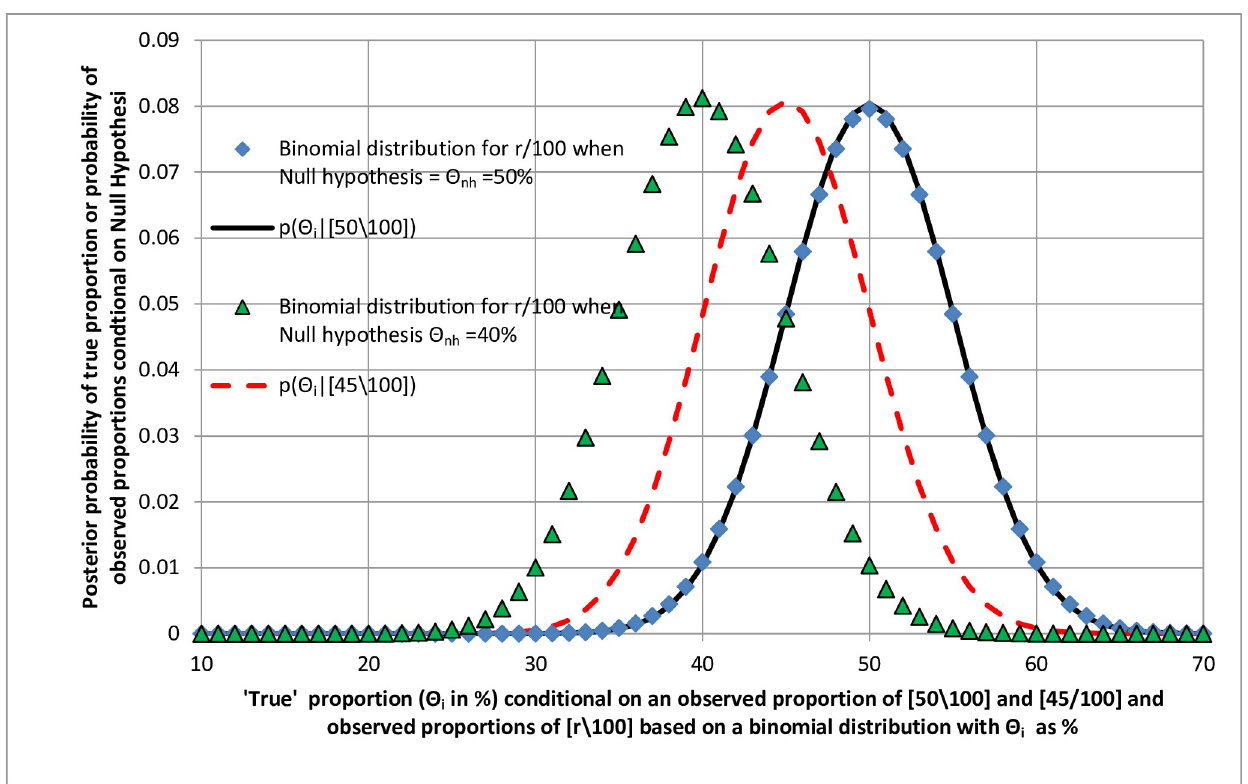
Fig 4. Comparing the probability of non-replication conditional on an observed proportion and one-sided P-values conditional on Null Hypotheses.